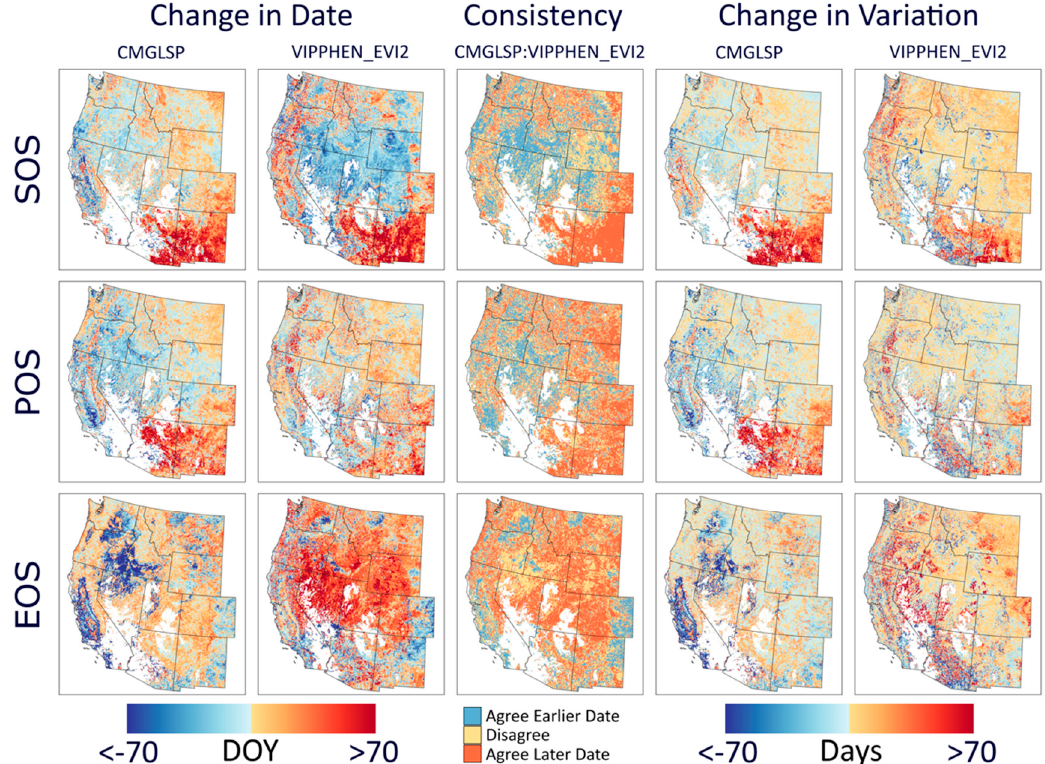
Figure 5. Change in date, consistency, and change in variation of CMGLSP and VIPPHEN_EVI2 across three phenology metrics from 1982 to 2016. Negative values correspond to earlier dates (or fewer days) and positive values to later dates (or more days). Consistency shows agreement in the direction of change between datasets. Change in date is the regressed trend slope multiplied by the number of years. Change in variation is the regressed trend slope, multiplied by the number of years, of the absolute value of the residuals of the trend estimate against time.